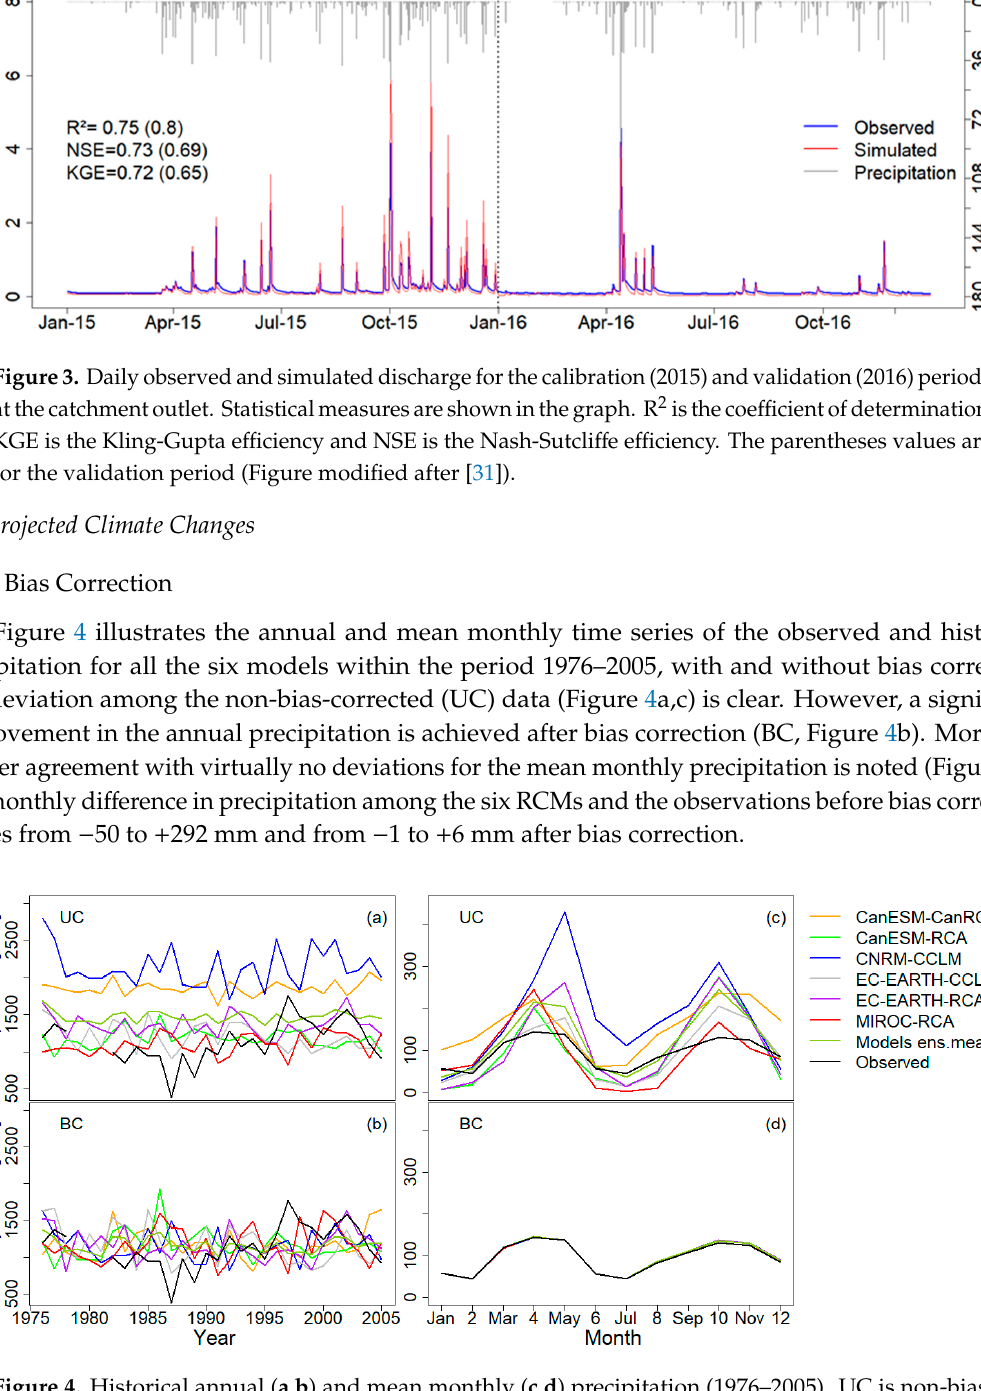
Figure 5. Exceedance probability for the six bias-corrected RCMs, their ensemble mean (arithmetic mean), and the daily observed precipitation for the period 1976-2005. Missing precipitation values were ignored in this illustration. Dry days were included in computation of the probability curve. Exceedance probability lines for observed precipitation and models are superimposed due to their similar exceedance probabilities after bias correction.